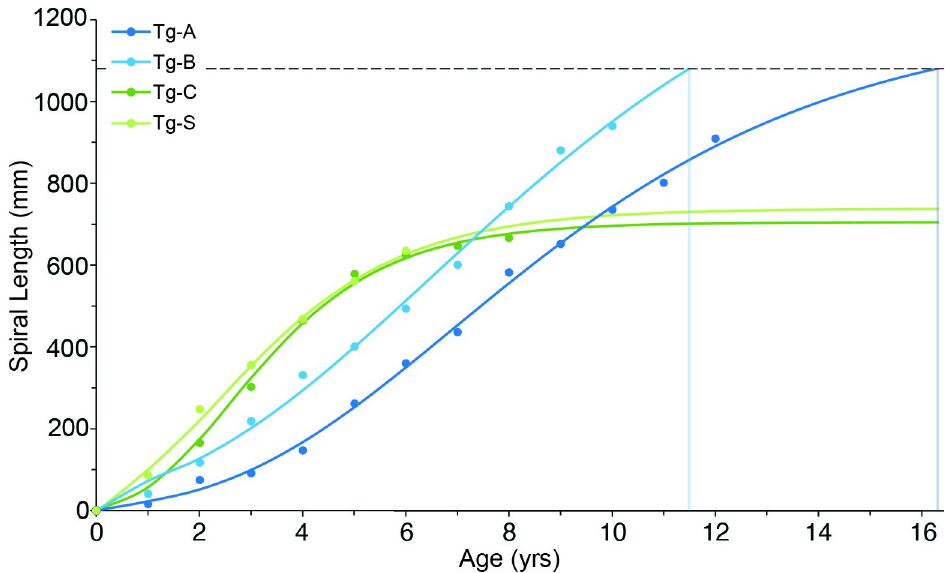
Fig 4. Triplofusus giganteus growth curves. Growth curves for Tg-A, Tg-B, Tg-C (this study), and a male specimen Tg-S [from Strauss et al., 21] modeled with spiral-length-at-age data from oxygen isotope profiles. The horizontal dotted line represents the measured spiral length of the record size shell. Vertical lines are placed at the intersection of growth curves with this horizontal line to show how long it would take for observed growth patterns in T . giganteus to produce the record shell